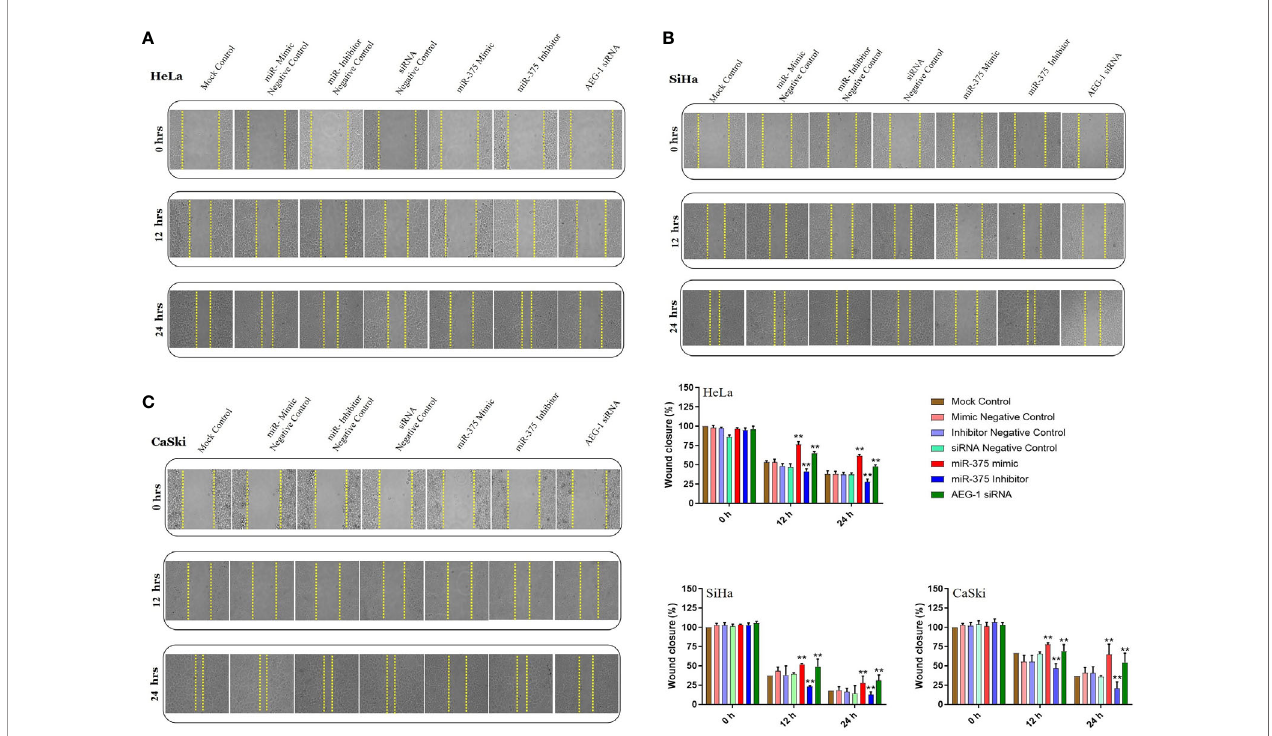
FIGURE 3 | Ectopic expression of miR-375 inhibits cervical cancer cell migration. in vitro scratch assay with HeLa (A) , SiHa (B) and CaSki (C) cell lines at 0, 12, and 24 h post-transfection with miR-375 mimic, miR-375 Inhibitor, AEG-1 siRNA and their controls. Gap distance of cells was quanti fi ed by using Image J. The scale bars represent 100 m m. Error bars represent mean ± s.d. and P-values are represented as **P < 0.05 compared to the corresponding controls at a different time